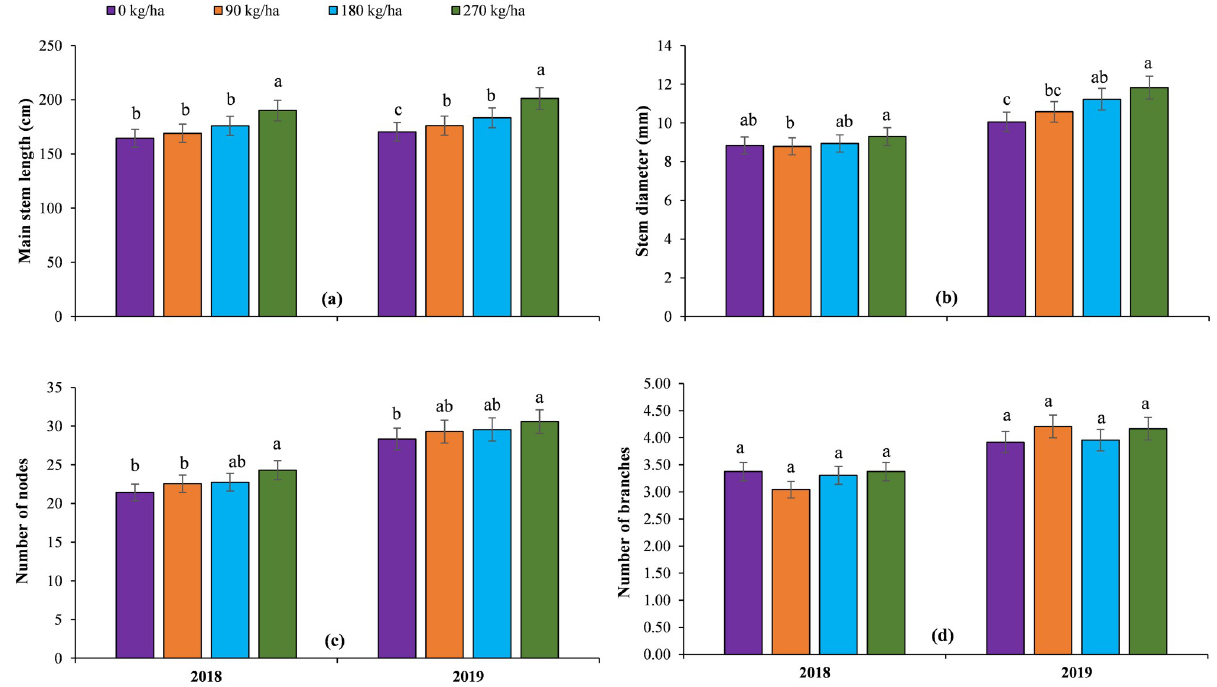
Fig 2. The impact of different nitrogen doses on pomological attributes of grafted watermelon under field conditions.